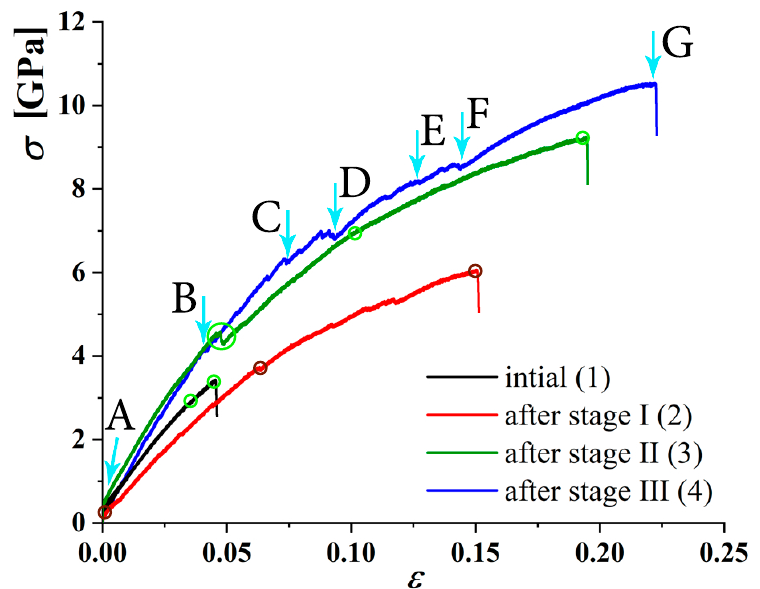
Figure 5. Stress–strain curves during tension normal to the interface region after different initial compression strain: after ε xy = 0.5 (2); ε xy = 1.0 (3), and ε xy = 1.6 (4).